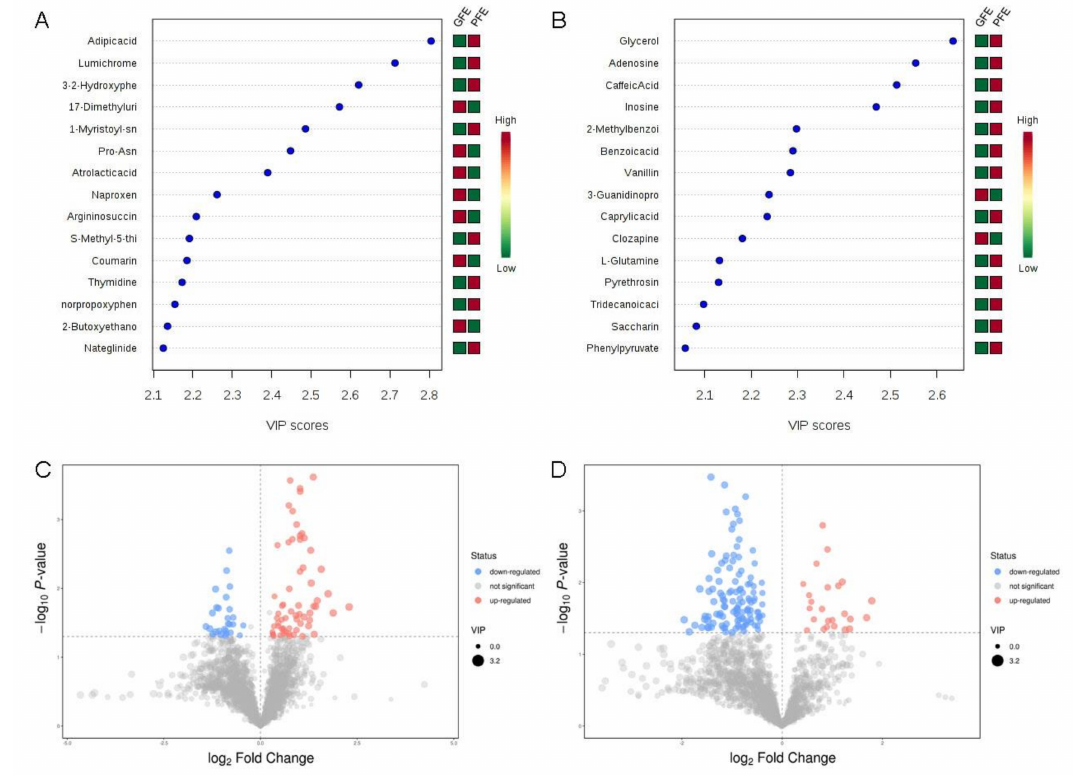
Figure 3. VIP value and volcano maps of metabolites. VIP scores of metabolites in GFE and PFE (TOP15) obtained in positive ( A ) and negative mode ( B ). The heat map with red or green boxes on the right indicates a high and low abundance ratio, respectively, of the corresponding metabolite in GFE and PFE. Volcano maps of metabolites in the positive ( C ) and negative ( D )